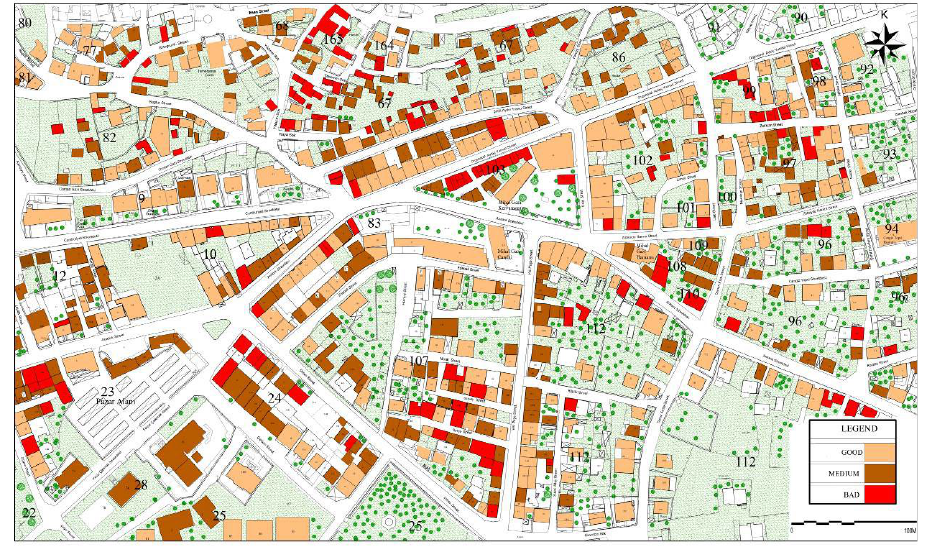
Figure 8 Gölpazarı district damage analyzes